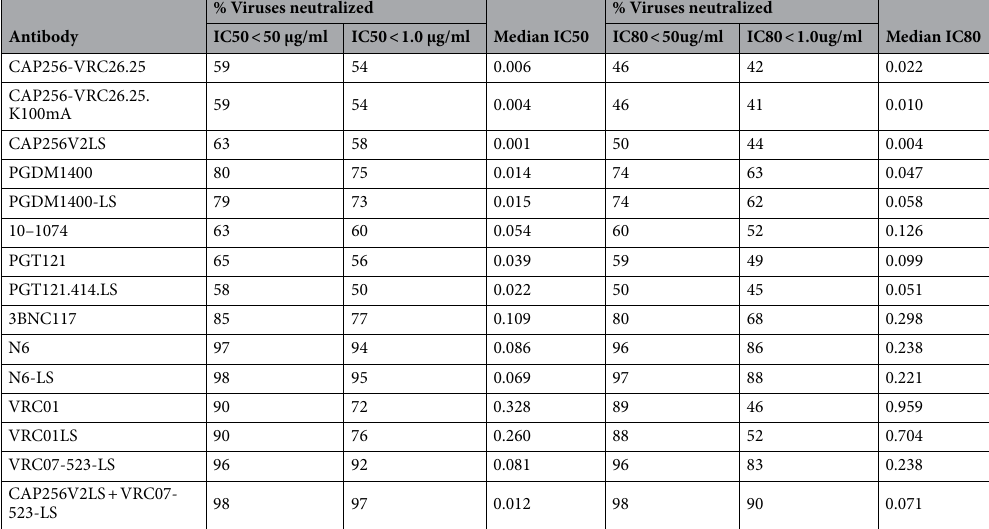
Table 1. Neutralization breadth and potency of monoclonal antibodies on a multiclade panel of 208 Env-